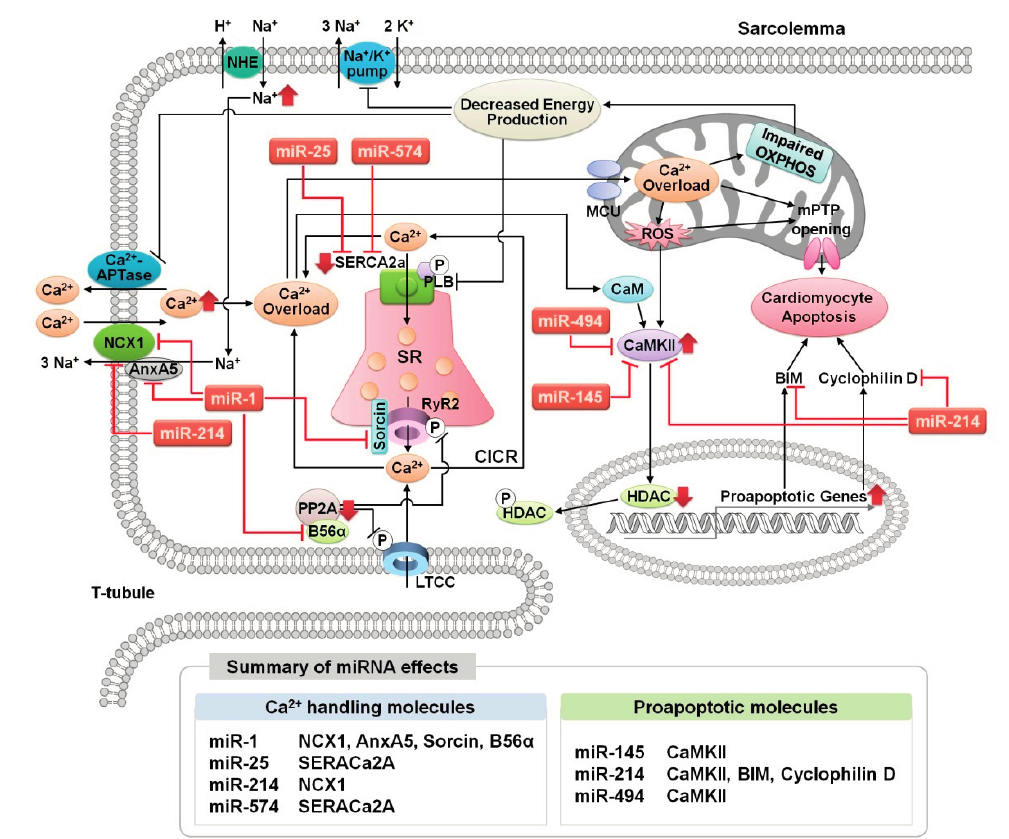
Figure 2. Cardiac Ca 2+ protein-regulated microRNA during ischemia-reperfusion injury. LTCC, L-type Ca 2+ channel; NCX, Na + /Ca 2+ exchanger; AnxA5, annexin A5; NHE, Na + /H + exchanger; CaM, calmodulin; CaMKII, Ca 2+ /calmodulin-dependent protein kinase II; RyR2, ryanodine receptor type-2; SERCA2a, sarcoplasmic reticulum Ca 2+ -ATPase; SR, sarcoplasmic reticulum; PLB, phospholamban; CICR, Ca 2+ -induced Ca2+ release; MCU, mitochondrial Ca 2+ uniporter; ROS, reactive oxygen species; CyP-D, cyclophilin D; mPTP, mitochondrial permeability transition pore; OXPHOS, oxidative phosphorylation; HDAC, histone deacetylase; P,